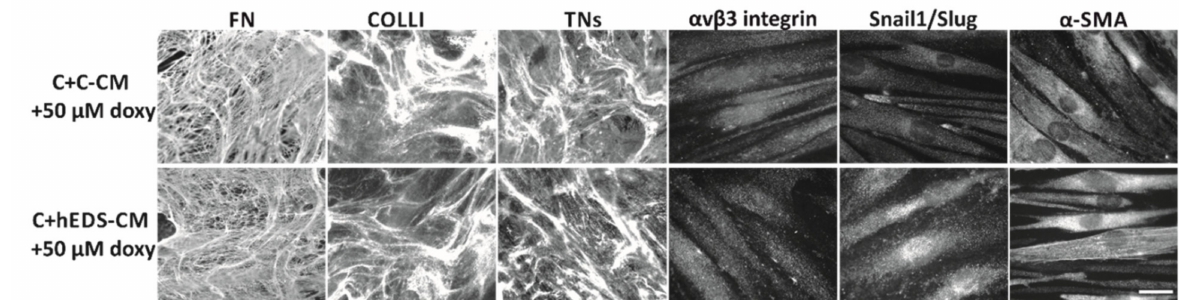
Figure 4. Doxycycline (doxy) abrogates the degradative and differentiation potential of hEDS-CM. IF analyses of FN-, COLLI-, and TNs-ECM organization, α v β 3 integrin and Snail1/Slug transcription factor expression, and α -SMA cytoskele- ton assembly in control dermal fibroblasts grown in the presence of a pool of CM, recovered from six 72 h-grown control (C + C-CM) and six hEDS (C + hEDS-CM) cell strains, supplemented with 50 µ M of doxy. Images are representative of three independent experiments. Scale bar: 12 µ